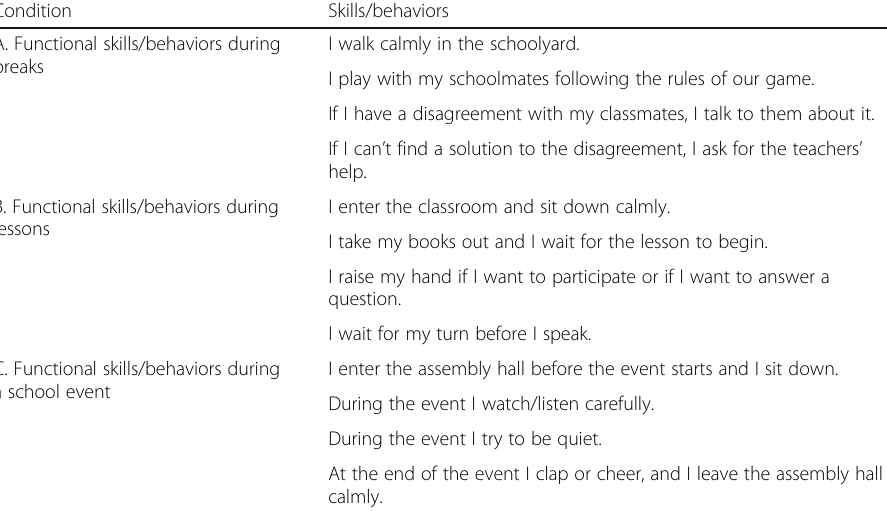
Table 2 Functional skills and behaviors for the three conditions (during breaks, lessons, and school events) Condition